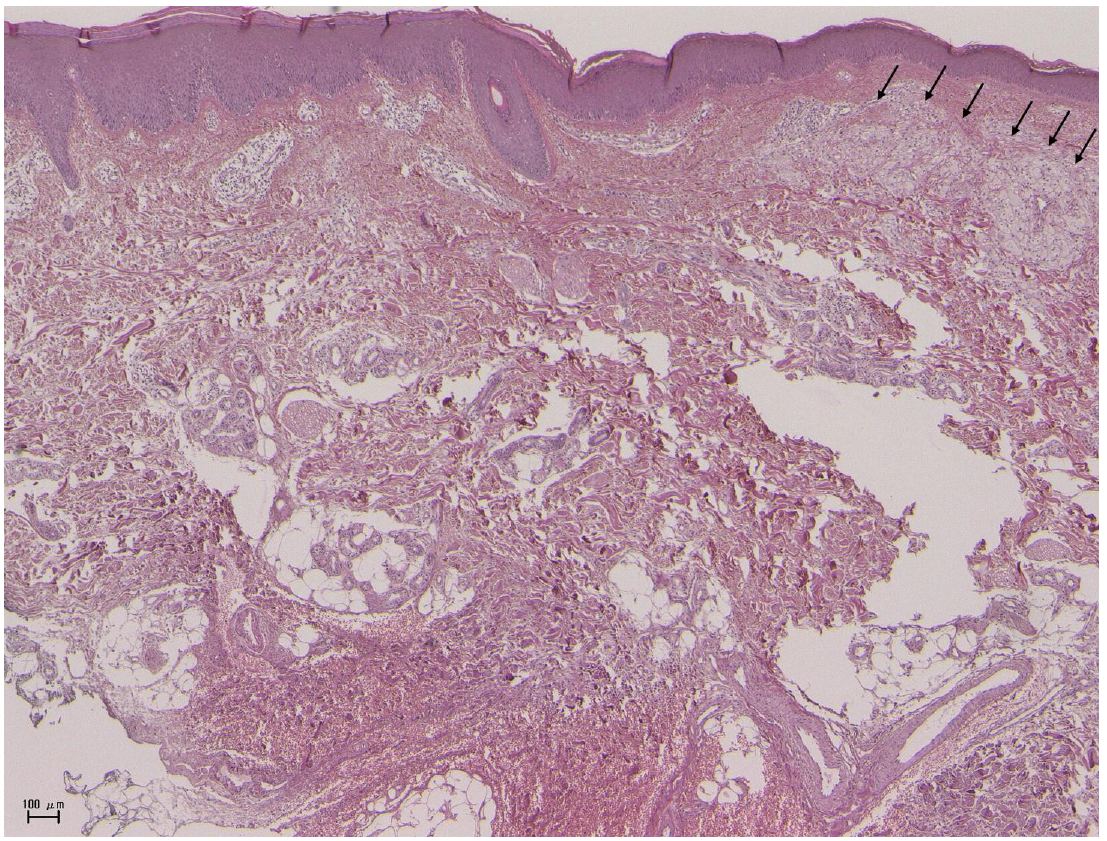
Figure 2. Biopsy specimen taken from a patient with psoriasis and SSc showing psoriatic epidermis (left side), dermal sclerosis, and xanthomatous foamy cells in the upper dermis (arrows). Scale bar: 100 μm.